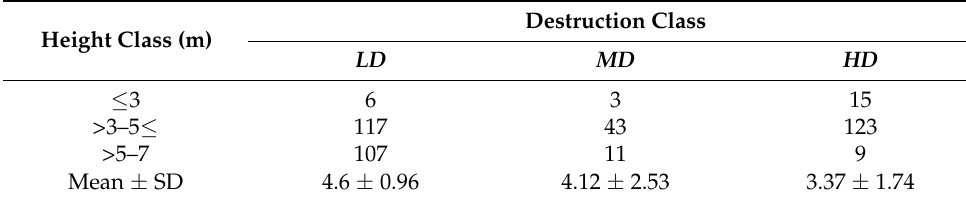
Table 4. Tree (DBH (diameter at breast height) ≥ 5 cm and height ≥ 1.5 m) density (no. ha − 1 ) by height classes (m) and destruction class in a naturally-regenerated broadleaf forest in the Arasbaran biosphere reserve in Iran ( n = 30). LD = Low Destruction, MD = Medium Destruction, HD = High Destruction. See Table 2 for description of a destruction